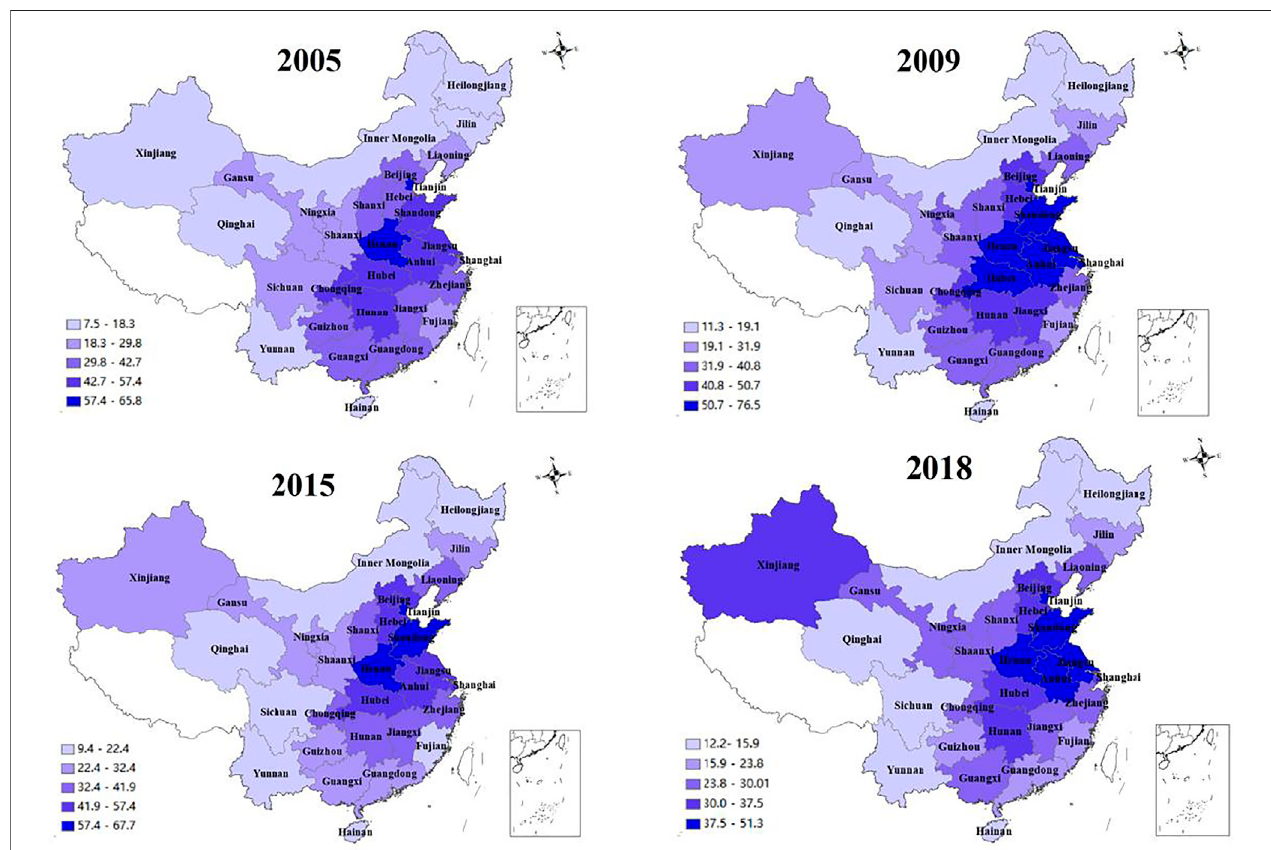
FIGURE 3 | Spatial distribution of